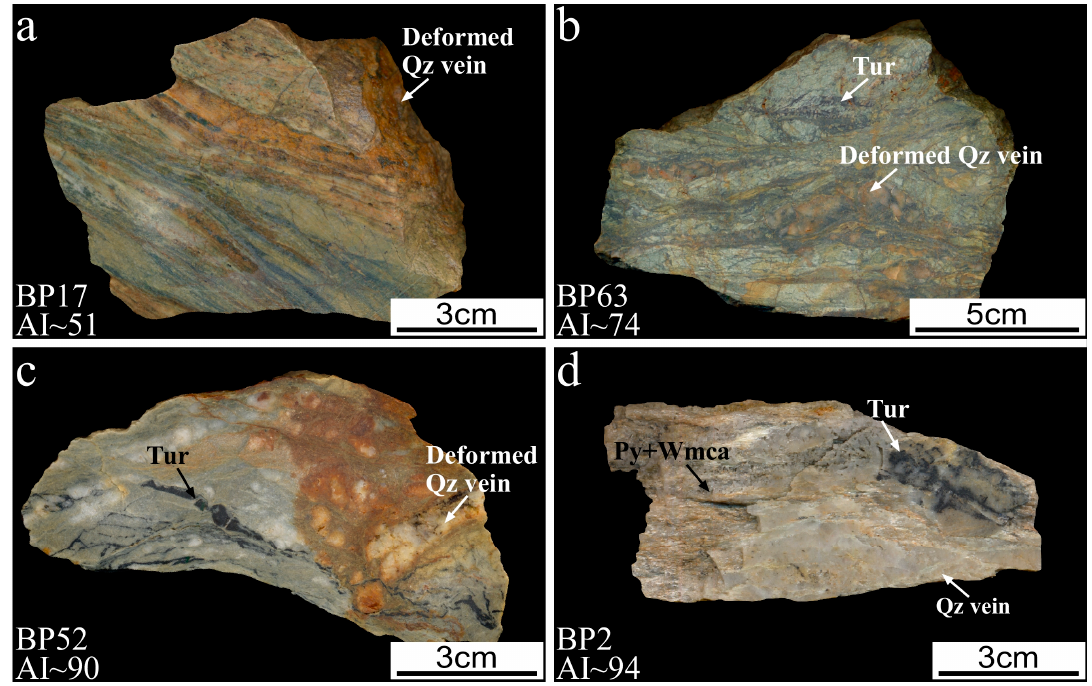
Figure 3. Polished slabs of “Filladi Inferiori” specimens from Sant’Anna tectonic window. ( a ) Phyllitic quartzite with alternance of quartz- and white mica+chlorite-rich levels with deformed milky quartz vein. ( b ) Phyllitic quartzite with intermediate features between least (e.g., a ) and most altered (e.g., c , d ) samples. See text for further details. ( c , d ) Whitish quarzitic phyllites with levels and pods of tourmaline and pyrite. AI: Alteration Index of Ishikawa. Mineral abbreviation: Py, pyrite; Qz, quartz; Tur, tourmaline; Wmca, white mica.